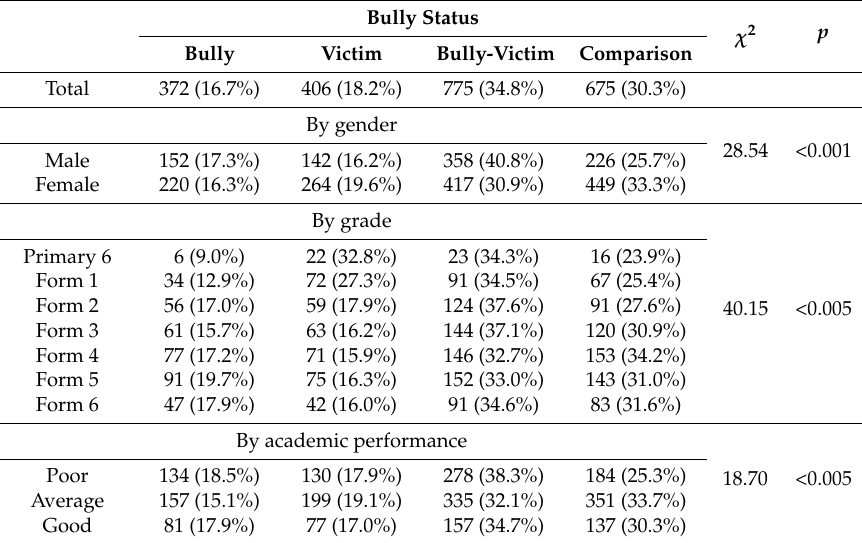
Table 2. Demographic variables across bully/victim